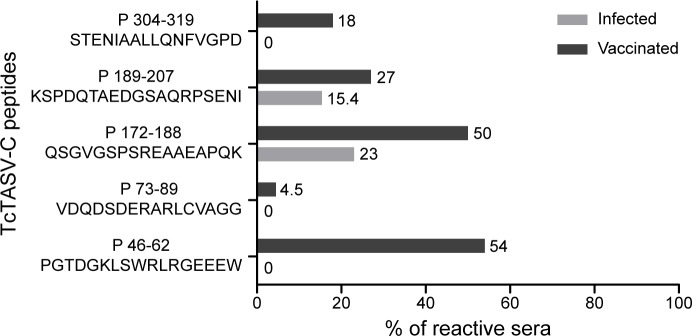
B-cell epitopes detected in TcTASV-C by sera from vaccinated mice.Sera from vaccinated (uninfected, n = 22) or infected (unvaccinated and TcTASV-C reactive, n = 13) mice recognized differential TcTASV-C peptides, evaluated in an ELISA format. Reactivity is expressed as % of sera that were reactive for each peptide. All sera were reactive against TcTASV-C proteins. Numbers in peptides indicate the amino acids of TcTASV-C encompassed by the peptide (i.e. P46-62, P172-188).